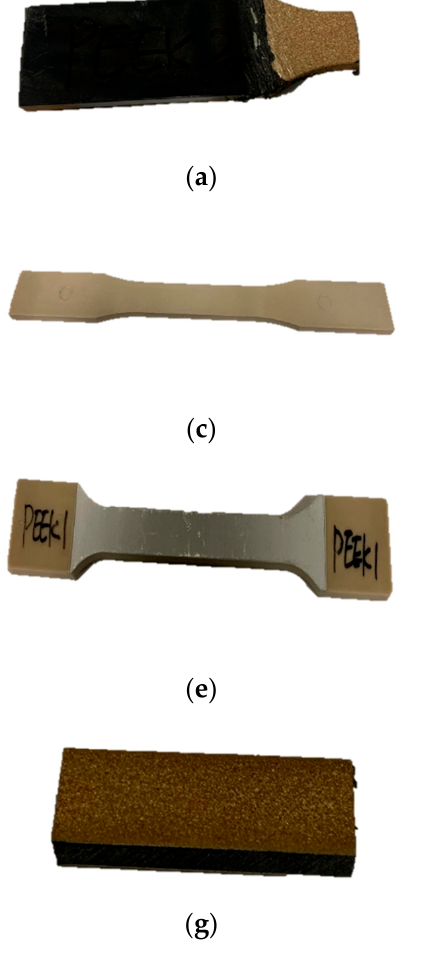
Figure 5. The samples were made of ( a ) PEEK; ( b ) PPA; ( c ) PPS; ( d ) zinc; ( e ) PEEK with aluminum coating; ( f ) PEEK with aluminum bronze coating; ( g ) PPA with aluminum bronze coating; ( h ) PPS with zinc coating.